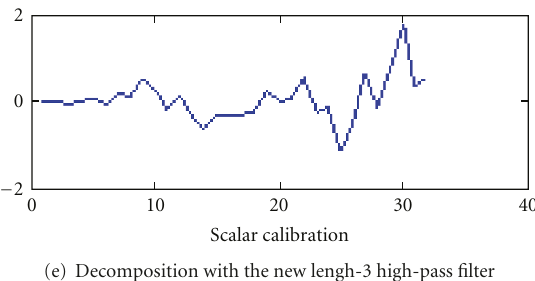
Figure 5: Decompositions of the test signal, prefiltered with Haar on interval [0,